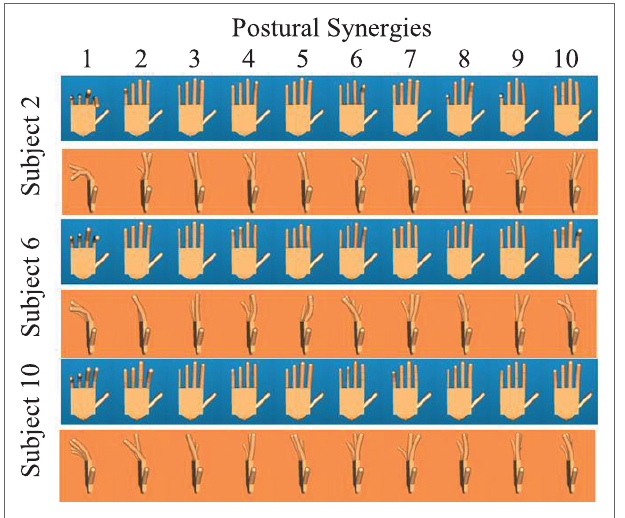
FigUre 8 | Front and side views of the 10 postural synergies for subjects 2, 6, and 10 are shown . Subjects were first trained on performing each of these postures. Then, images of the hand imitating these postures were taken.